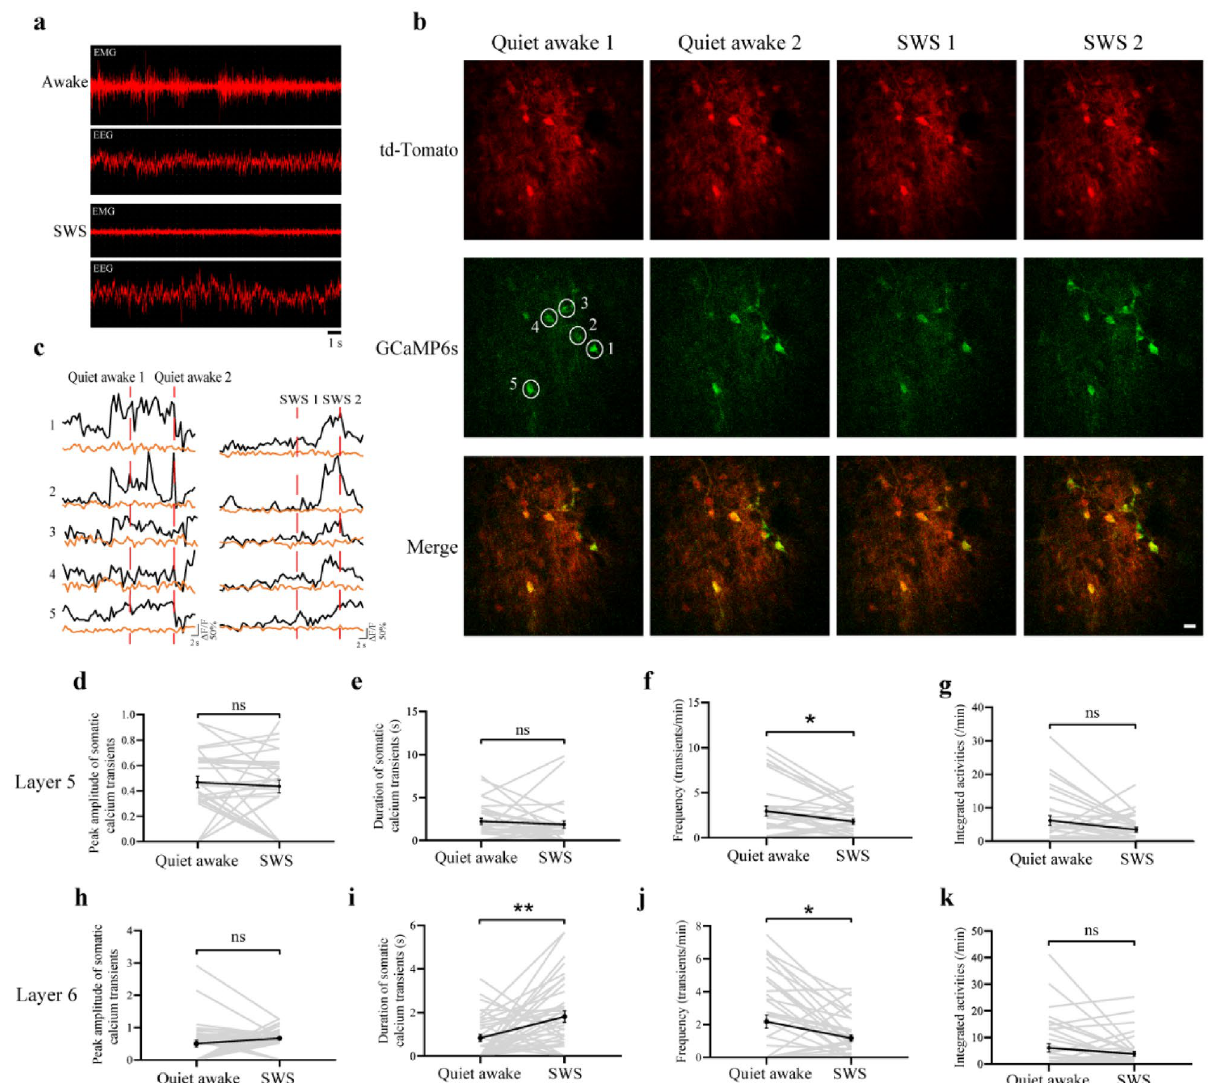
(Orange) and calcium (Black) fluorescence traces of somas circled in (b) during the quiet awake and sleep states in layer 5 of motor cortex. ( d-g ) The peak amplitude ( d ), duration ( e ), frequency ( f ) and total integrated activity ( g ) of somatic Ca 2+ transients during quiet awake and slow wave sleep states in layer 5 of rabbit motor cortex (30 somas from 2 rabbits. Total of 29 quiet awake episodes and 28 SWS episodes. Quiet awake vs. SWS: P = 0.5833, 0.4761, 0.0145 and 0.0607 for amplitude, duration, frequency and total integrated activity, respectively). ( h–k